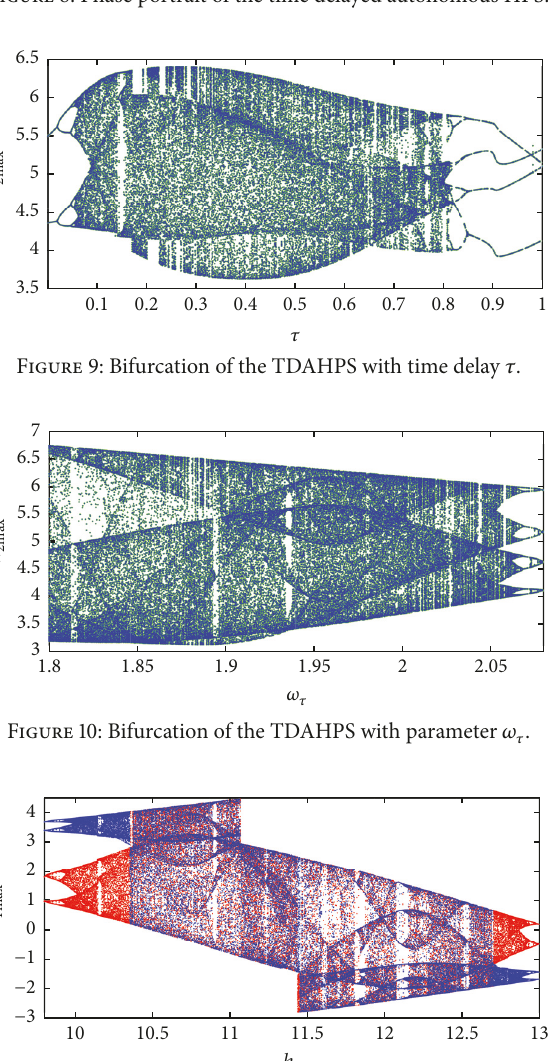
Figure 11: Multistability in TDAHPS with the red plots showing the forward continuation (increase in parameter ℎ 𝜏 from 9.8 to 13 ) and blue plots showing backward continuation (decrease in parameter ℎ 13 to 9.8 ) with reinitializing of the initial 𝜏 from